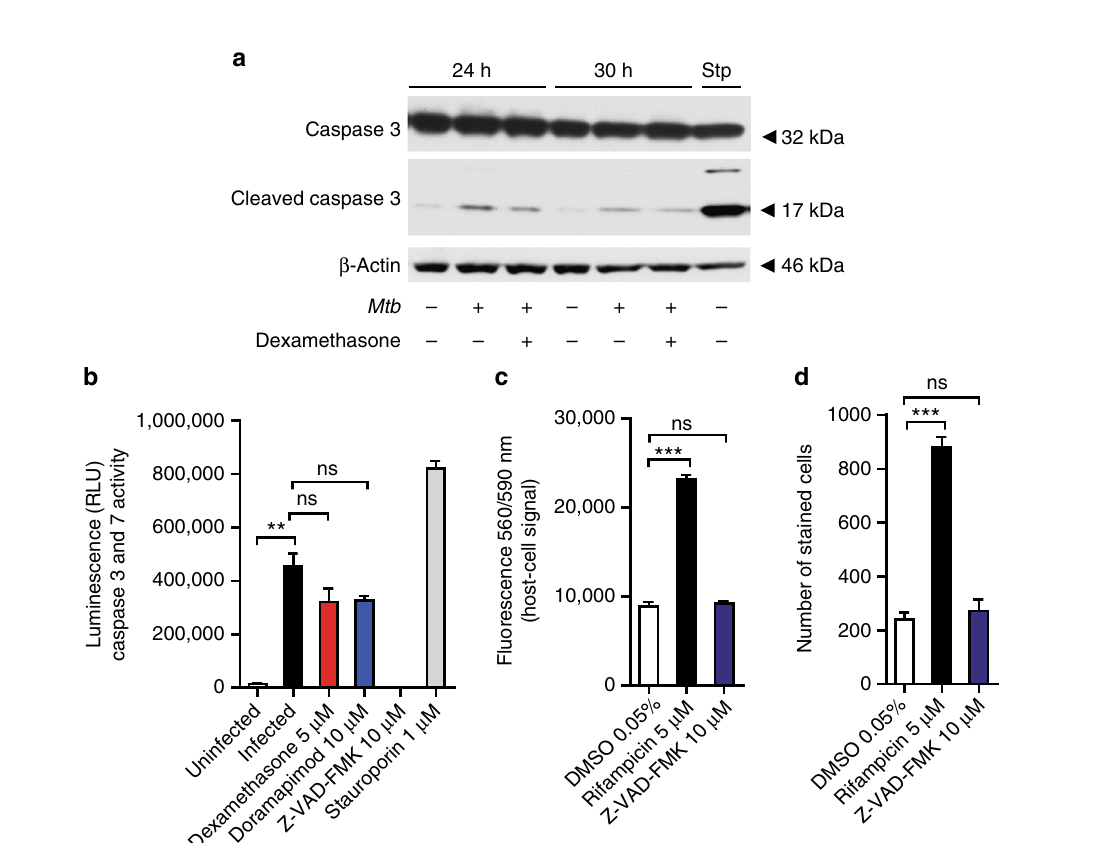
Fig. 3 Mtb -induced cell death is independent of caspase activation. a Western blot analysis of proteolytic cleavage of caspase 3 in Mtb -infected J774.2 M φ (MOI 5). Equal amounts of protein from infected J774.2 M φ treated with or without dexamethasone (5 µ M) were subjected to immunoblot analysis for cleaved caspase 3 following 24 and 30 h of infection. β -Actin was used as a loading control and staurosporine (1 µ M) as a positive control. Images are representative of two individual experiments. b MRC-5 lung fi broblasts were infected with Mtb (MOI 10) and treated with dexamethasone (5 µ M),